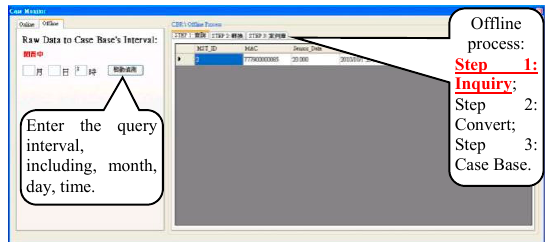
Figure 12. Off-line: Inquiry. Figure 12. O ff -line: